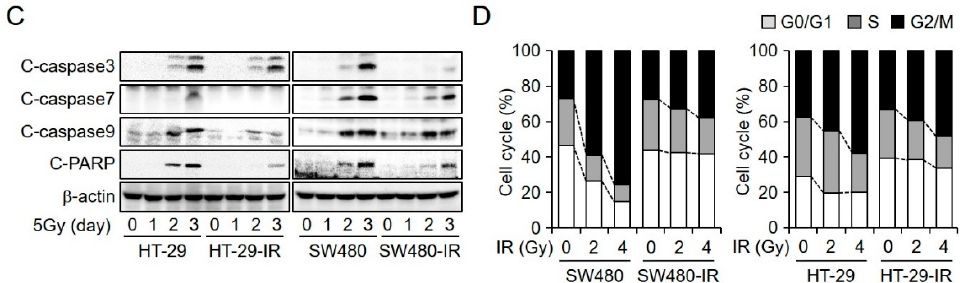
Figure 1. Establishment and characterization of irradiation-resistant colorectal cancer cell lines. ( A ) A